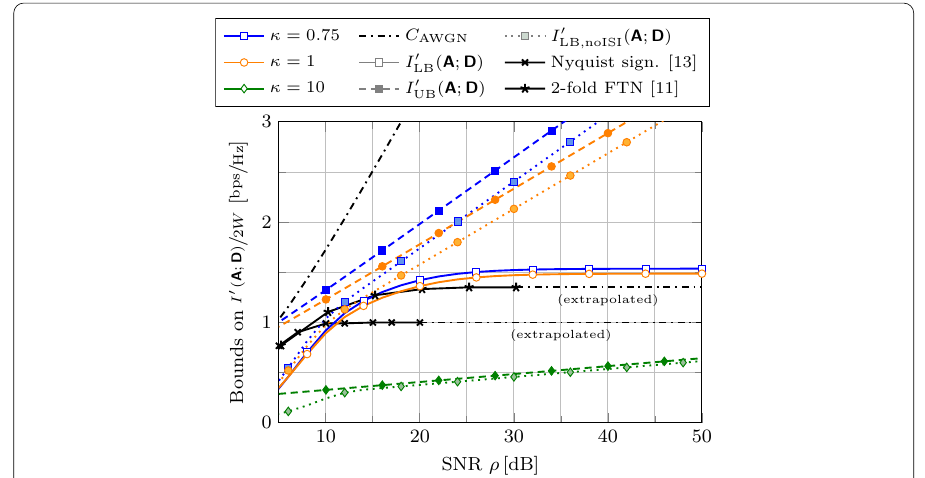
D )/( 2 W ) . The bounds depend on the SNR ρ ;